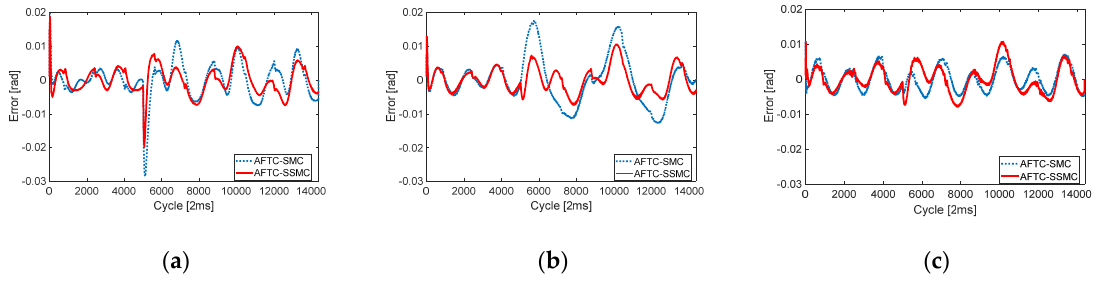
Figure 14. The error at joints with multiple faults. ( a ) Joint 1; ( b ) Joint 2; ( c ) Joint 3.